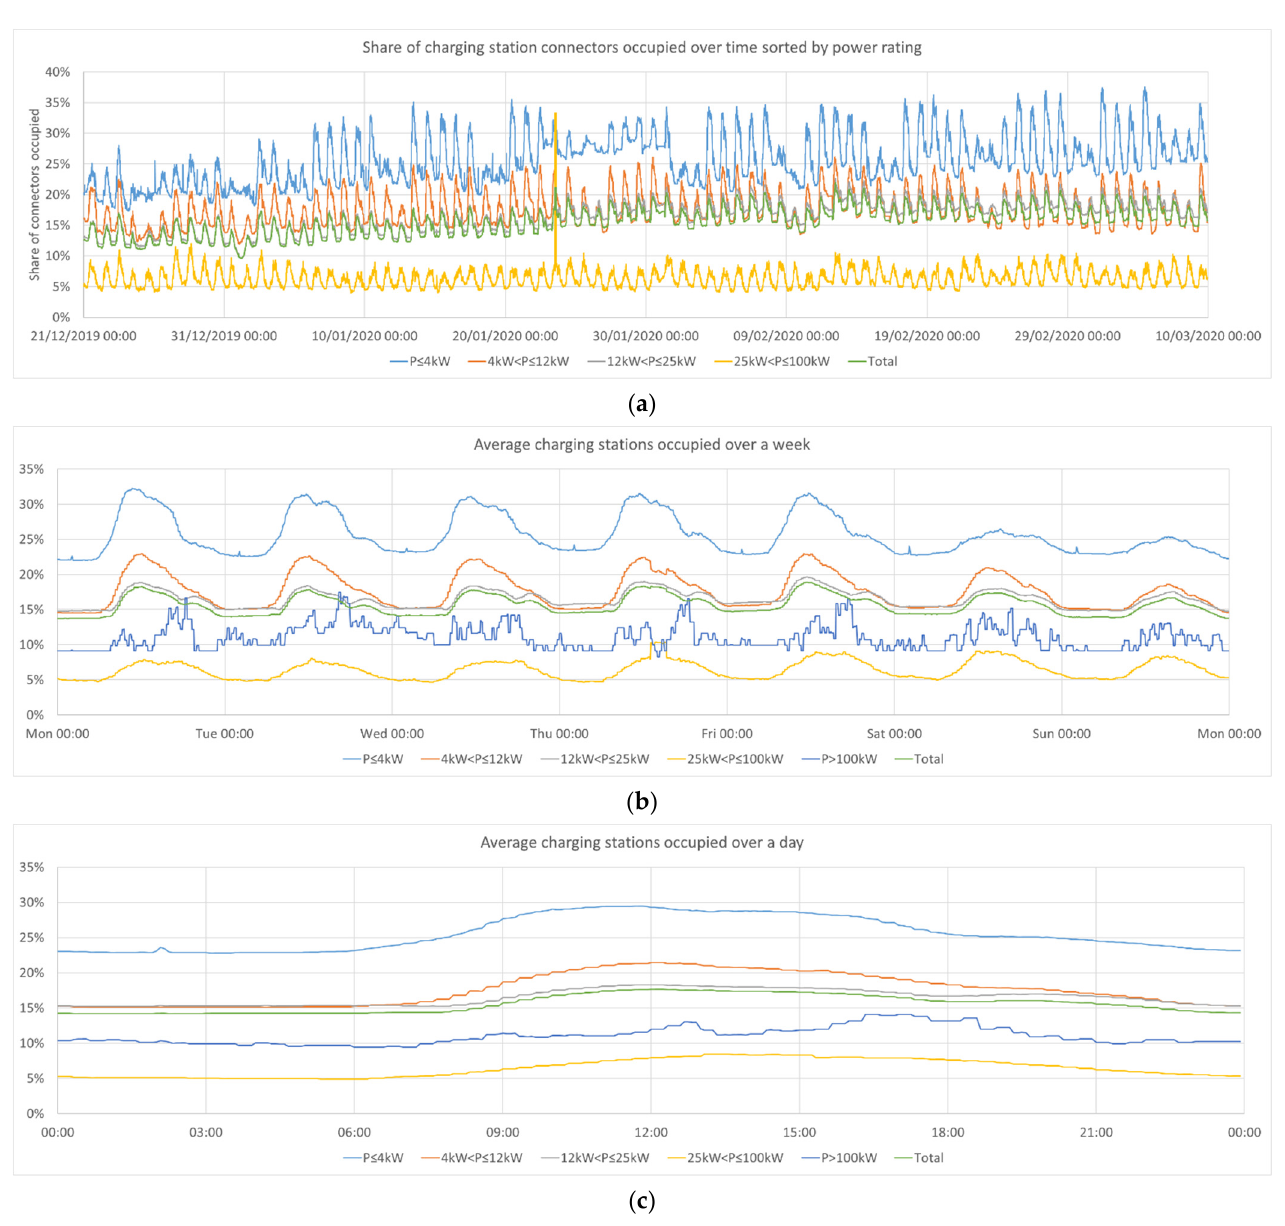
Figure 5. Share of the charging station connectors that were occupied at each moment in time by power rating. For each power rating, the number of connectors marked as occupied was divided by the sum of the connectors for which the status was known: ( a ) the occupation rate over the entire observed period; ( b ) aggregated on a weekly level; ( c ) aggregated on a daily level. Note that the peak on 23 January 2020 as well as the small peaks at approximately 2:10 in the morning were reported by the observed websites but likely represent a fault in the IT system on the remote end. The data and their description are a direct copy from our previous publication and repeated here for the reader’s convenience [2] (This article was published in eTransportation , volume 6, Hecht, C.; Das, S.; Bussar, C.; Sauer, D.U., Representative, empirical, real-world charging station usage characteristics and data in Germany, 100079, Copyright Elsevier 2020).